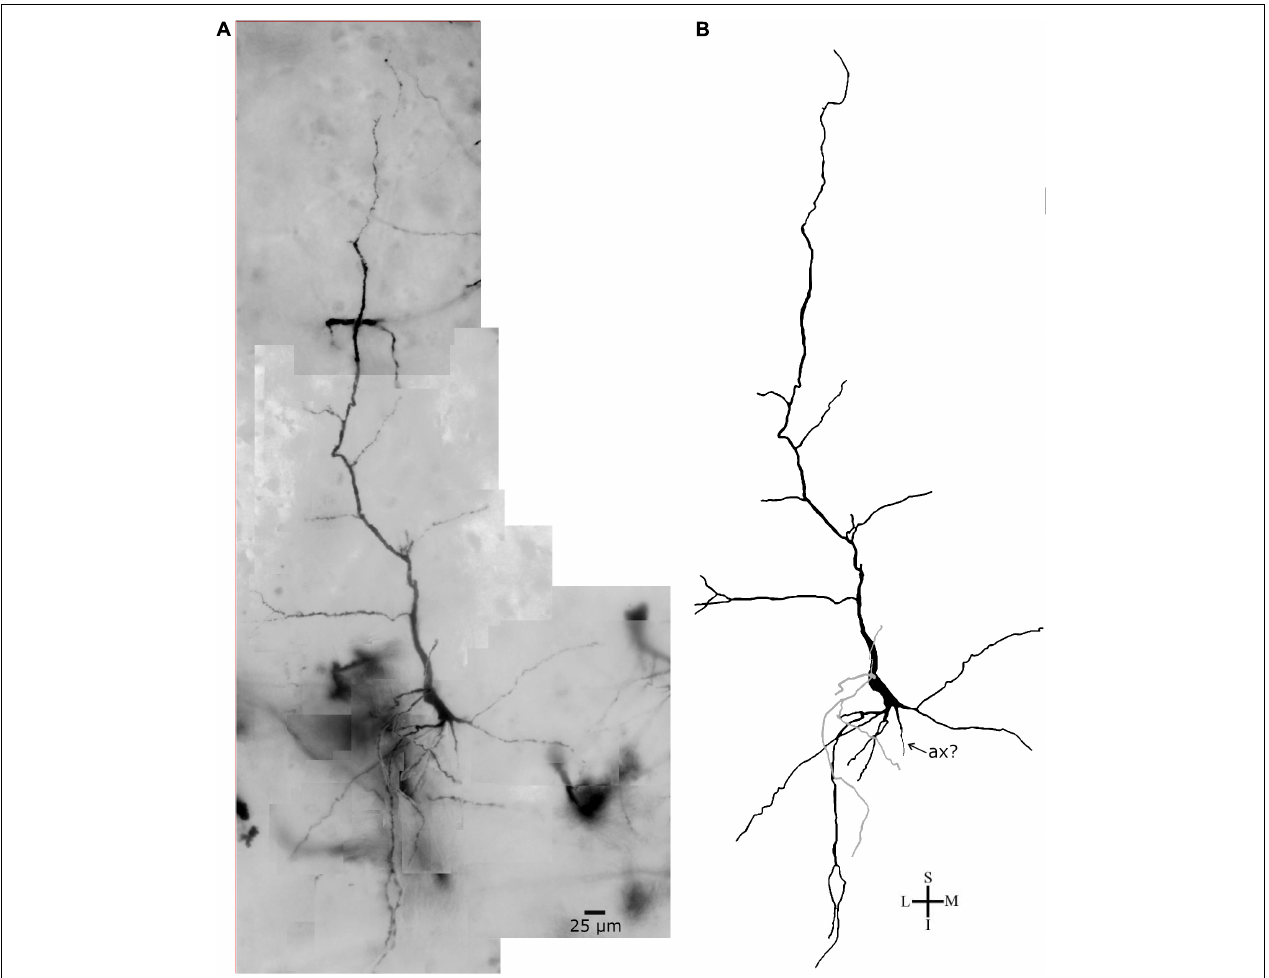
FIGURE 12 | (A) Photomicrographic composition of a Golgi-impregnated spindle- to rod-shaped neuron from the inner layer VI in the human precuneus (central region, 61.1 mm posterior to the midpoint of the anterior commissure) observed using brightfield microscopy. (B) Two-dimensional image reconstruction of the same neuron in (A) (pial surface at the top). Note the elongated cell body shape, two main longitudinally oriented primary dendrites with various branching points, a third thinner primary dendrite arising from the cell body (colored in gray). Note the thick aspect of the descending primary dendrite, its ramification in secondary branches, and a process that would be an axon hillock (ax, indicated by an arrow). The axon extent or its ramification are not visible. Image reconstructed using the Neuromantic software (University of Reading, United Kingdom) with adjustment of contrast made with Photoshop CS3 (Adobe Systems, Inc., United States). Coordinates in (A,B) : I, inferior; L, lateral; M, medial; S, superior. Scale = 25 µ